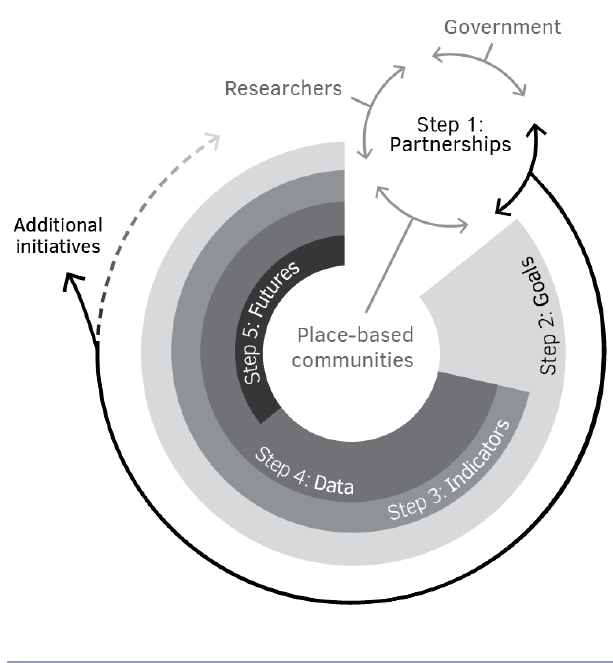
Fig. 2. The five major steps of the biocultural approach used in this study. The steps were staged to begin at different times and proceeded